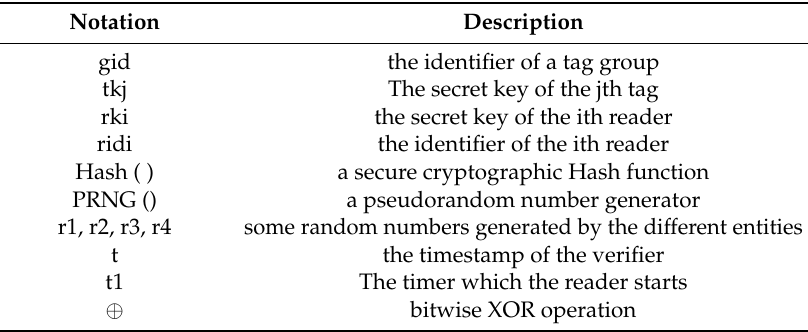
Table 1. The symbols used in our proposed